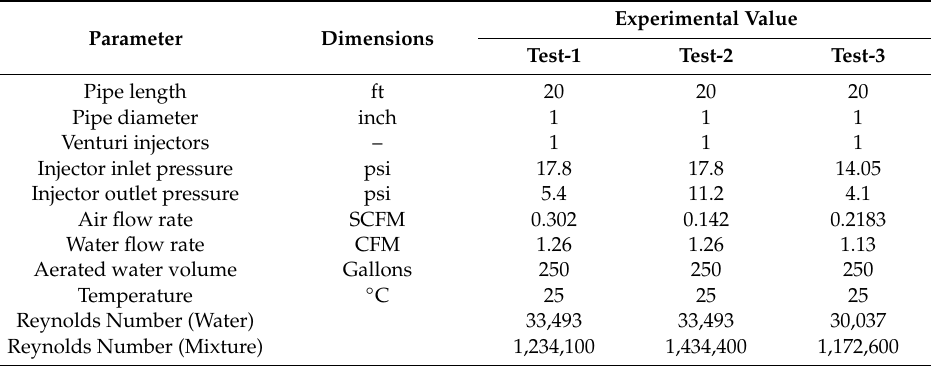
Table 2. Di ff erent physical